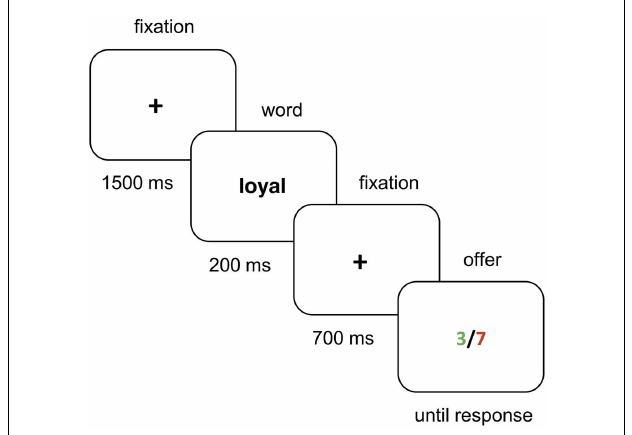
FIGURE 1 | Sequence of events in a